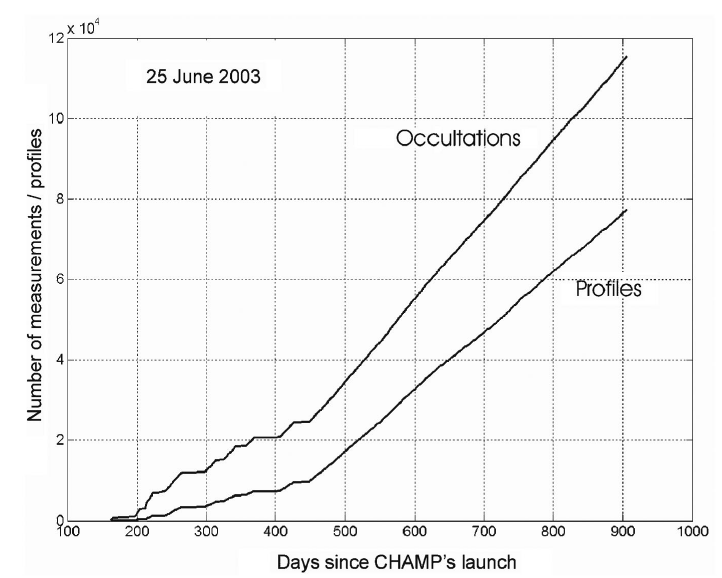
Fig. 7.1. Statistics of the number of measured GPS radio occultations on CHAMP and corresponding derived vertical electron density profiles.